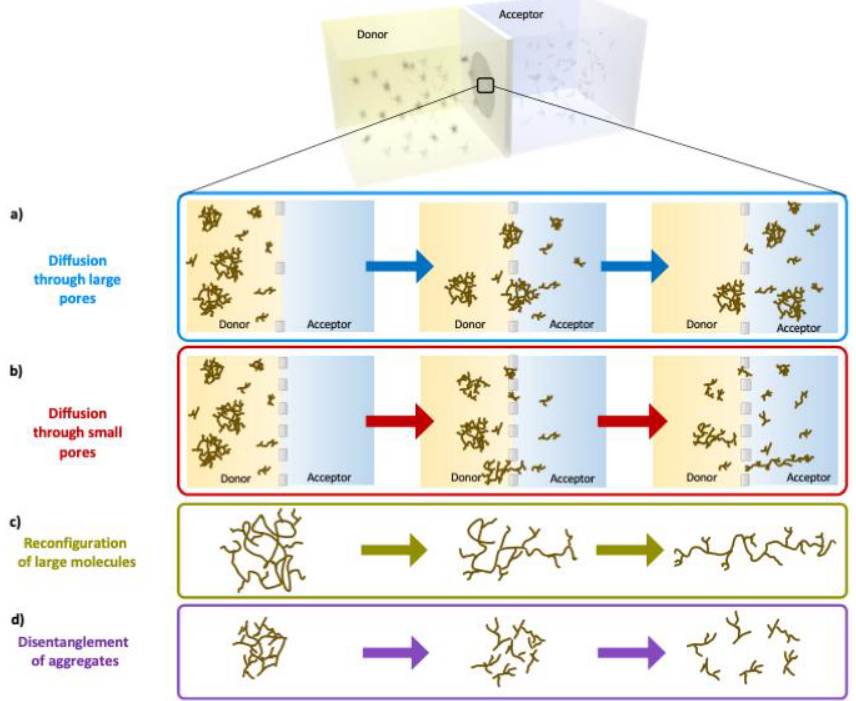
Figure 6. Schematic diagram of the diffusion of lignin molecules through membranes in diffusion cells ( a , b ), disentanglement/dissociation of lignin clusters that allows them to pass through a mem- brane ( c ), and reconfiguration of large lignin molecules that enables them to pass through a membrane via a reptation-like mechanism ( d ).